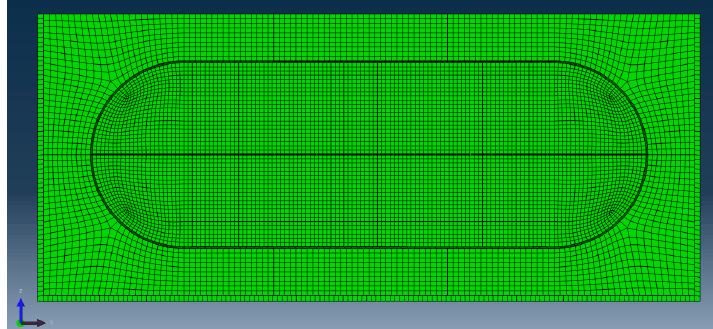
Figure 6. Elements of analysis model.